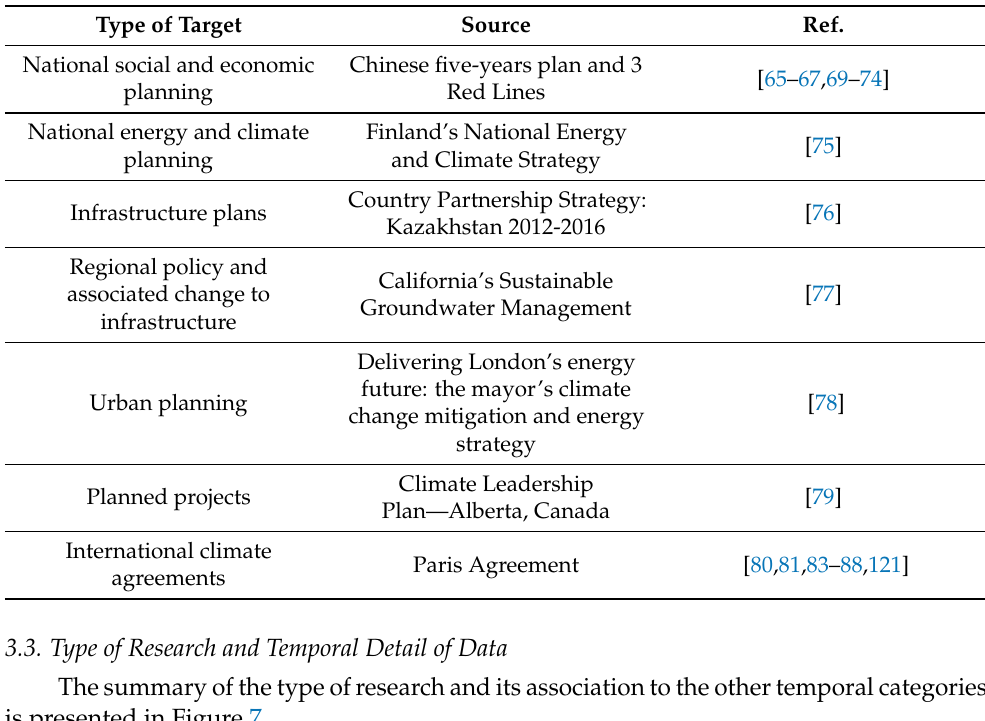
Table 2. Summary of type of temporal targets and their sources.